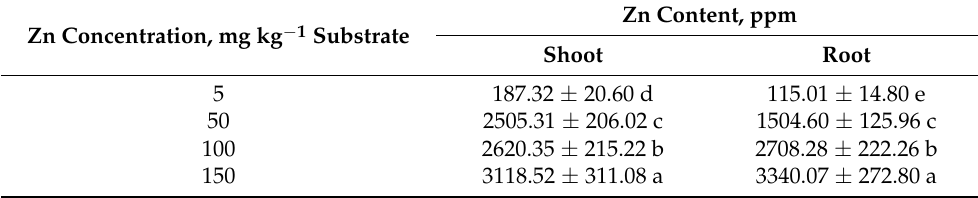
Table 1. Effect of Zn excess on Zn accumulation in shoots and roots of S. alba seedlings. Zn Concentration, mg kg − 1